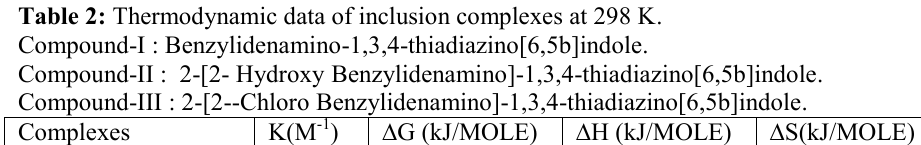
Table 2: Thermodynamic data of inclusion complexes at 298